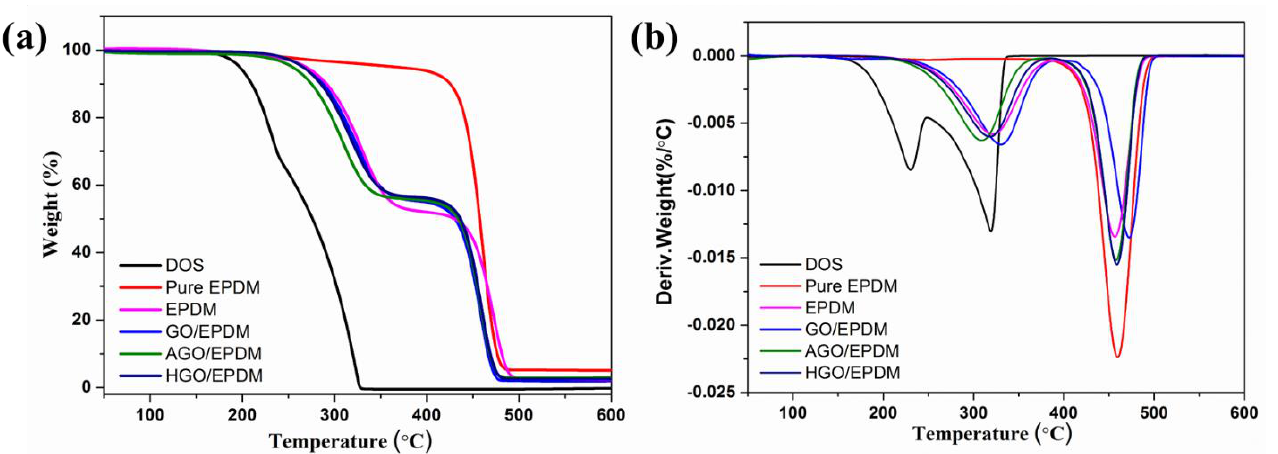
Figure 7. Thermal analysis of the EPDM insulation, TG ( a ) and DTG ( b ) curves.